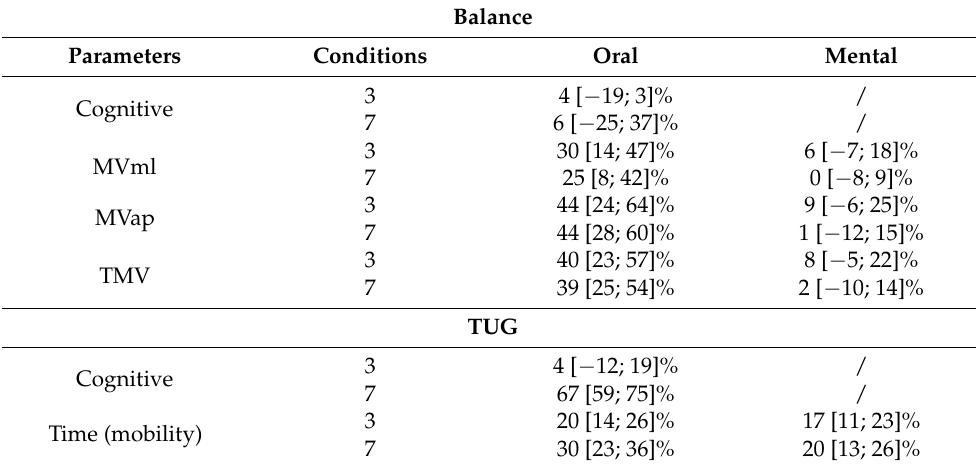
Table 3. Dual-task costs for the different studied parameters. Mean [95%